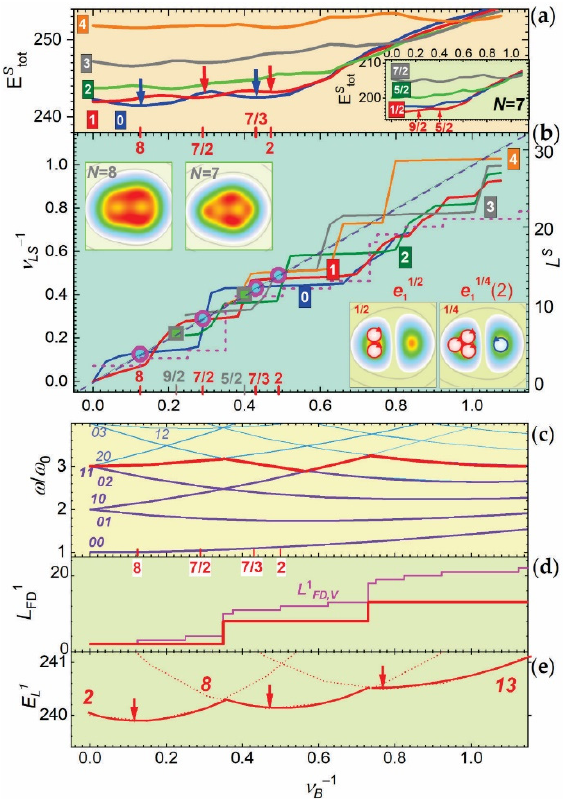
Figure A2. Total energy E S tot ( a ) and reduced total angular momentum ν LS − 1 = L S / L 0 ( b ) for different S (solid curves marked by numbers) versus reduced field ν B − 1 for ħω 0 = 5.8 meV and N = 8 calculated by CI method. Insert in ( a ) presents E S tot for N = 7. Vertical arrows in ( a ) mark GSs (see composition numbers on ν B − 1 axes). The dashed line in ( b ) is the ν L − 1 = ν B − 1 dependence, circles(squires) mark GSs for N = 8(7), dashed curve is the L FD, V 1 function (see also ( d ). The inserts show calculated total CCD (upper) for at N = 8 (left) and N = 7 (right) at B =0 T and HF EDD of 1 p x single particle state (lower) with V s (circles with arrow, showing circulation direction), corresponding to e 1/2l em (left) and its MM (right). The CCD and EDD size is 100 × 100 nm 2 . FD spectrum (dark and light color curves are occupied and unoccupied levels, respectively) E k,l FD ( ν B − 1 )/ ħω 0 * calculated for ħω 0 * = 3.5 meV ( c ) to- gether with total angular momentum (thick curve) L FD 1 ( ν B − 1 ) ( d ) and energies (thin dot curves) E L 1 ( ν B − 1 ) of N = 8 and S = 1 (see thick lines outlining topmost levels in ( c )) ( e ). Thick solid lines in ( e ) outline minima of E L 1 ( ν B − 1 ) and vertical arrows mark corresponding GSs. Thin line in ( d ) is L FD, V 1 function.